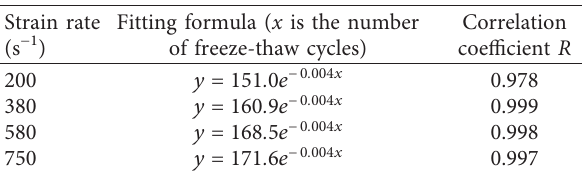
Table 4: Dynamic compressive strength fitting formula of freeze- thaw cycle sandstone under different strain